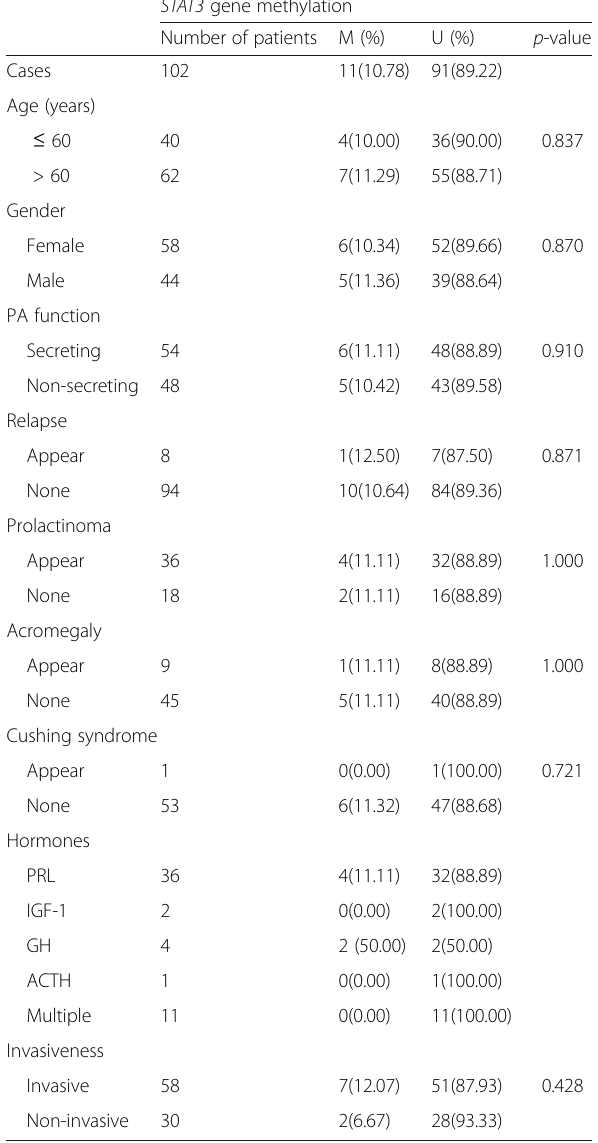
Table 1 Relationship between STAT3 promoter methylation, patient clinical characteristics and PA invasiveness